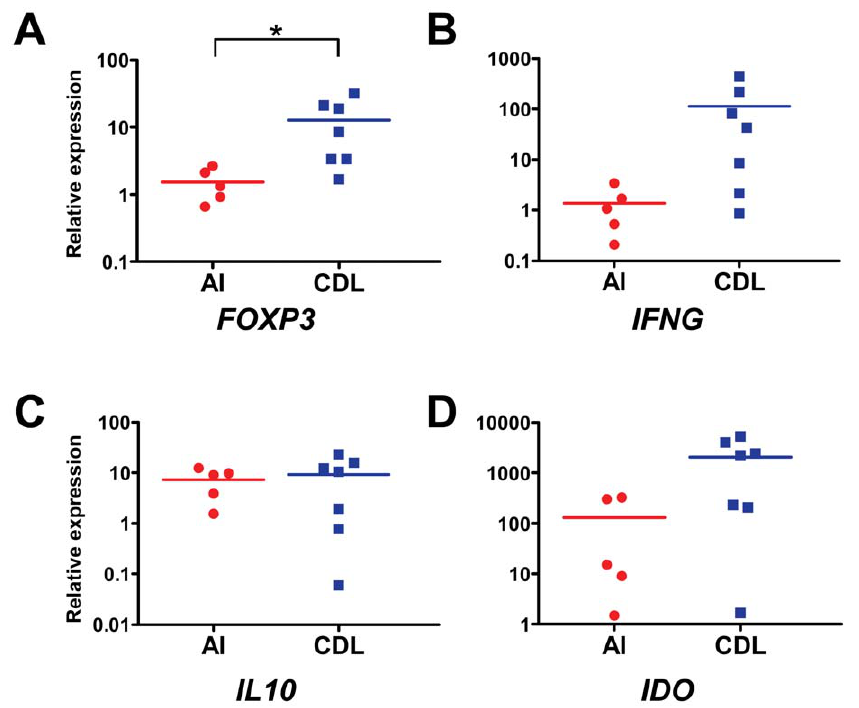
Figure 3. Relative expression of FOXP3 is higher in leishmanin skin test (LST) sites from CDL patients. RNA was isolated from biopsies of LST sites from AI (n=5) and CDL patients (n=7) and the expression of FOXP3 ( A ), IFNG ( B ), IL10 ( C ) and IDO ( D ) was measured by qRT-PCR. The expression of each gene relative to healthy skin of four normal controls was calculated using the DD CT method. *p , 0.05, unpaired t-test. The median is represented by a horizontal